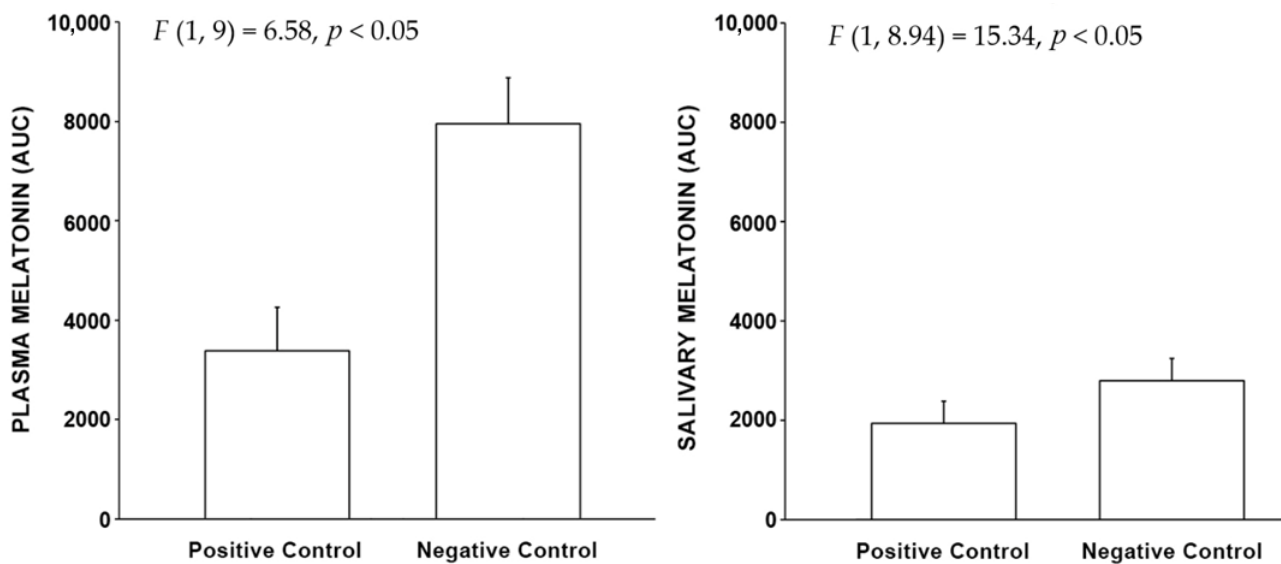
Figure 2. The bars shown above represent the mean (+ SEM) AUC plasma and salivary melatonin levels for the positive and negative control conditions. The integrated melatonin AUC values were calculated from the raw plasma and salivary melatonin values shown in Figure 1 for the exposure period only (1:00 AM to 3:00 AM). The statistics are based on the LMM.